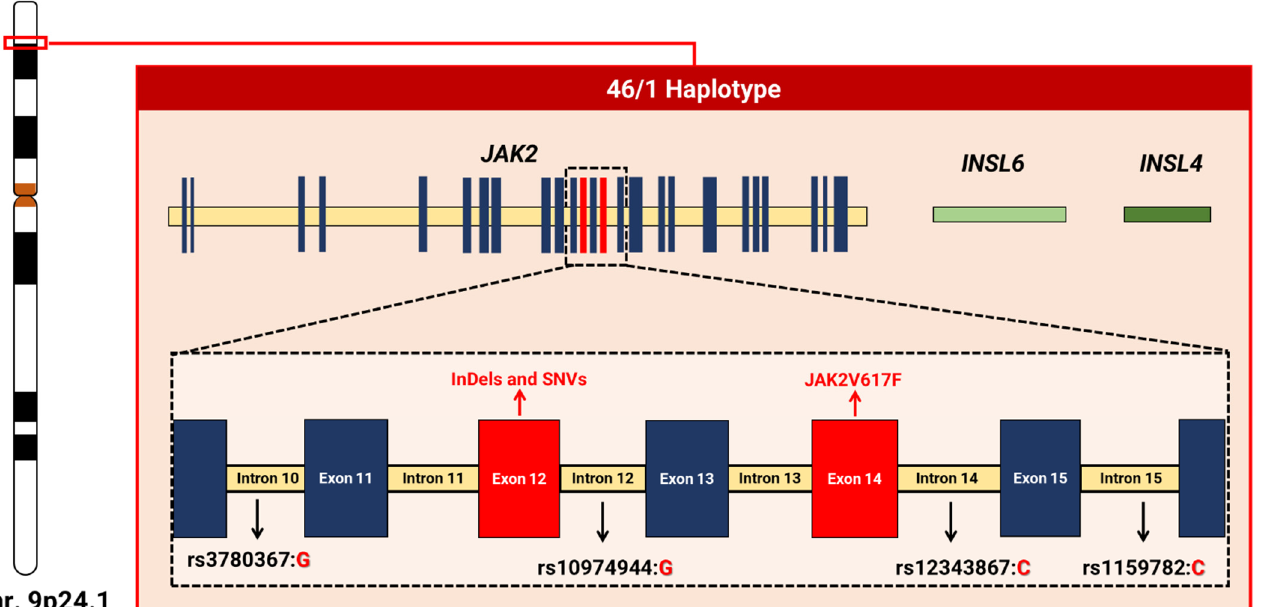
Table 2. Single nucleotide variants (SNVs) identified in studies on the 46/1 haplotype and their respective information described in the